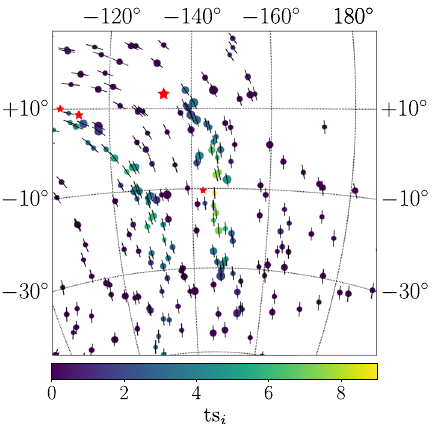
Fig. 13 Example realization of arrival directions from the benchmark 2 simulation with a source density of ρ S = 10 − 2 Mpc − 3 . The strongest of the sources (red star symbols) at Galactic longitude l ≈ − 133 ◦ and Galactic latitude b ≈ 14 ◦ contributes with 29 cosmic rays. Sizes of the cosmic-ray events (colored circles) correspond to the energy E , the color code to the individual test statistics ts i , and the short black lines indicate the tangent vector field ˆ u 0 , i.e. the orientation of the major-axis of the ellipses